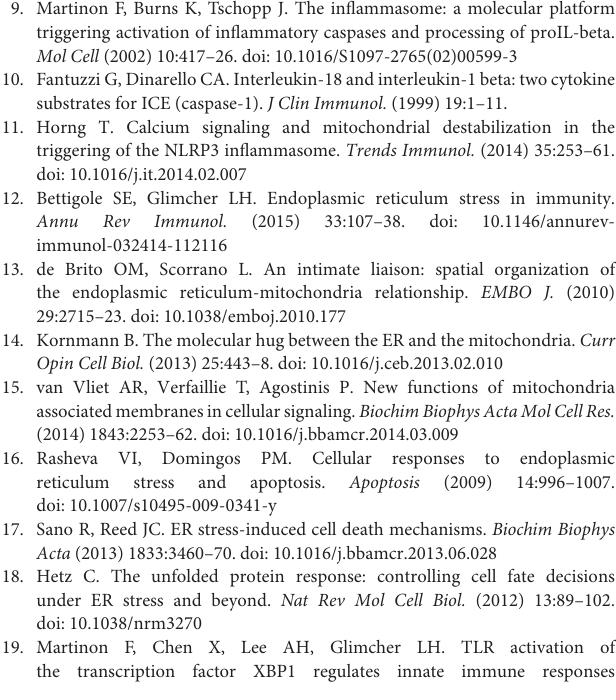
Supplementary Figure 3 | ERS mediates M. bovis -induced inflammasome activation in vivo . Related to Figure 6 . (A) ELISA analysis of serum TNF- α and IL-6 in mice treated with or without 4-PBA (18.6 mg/mouse/day) and infected with M. bovis (CFU 200) ( n = 3). (B) Clinical scores of mice infected with M. bovis (CFU 200) for 3 weeks or 6 weeks in the presence or absence of 4-PBA (18.6 mg/mouse/day). (C) Bacterial burden (acid-fast staining) in the lung of mice infected with M. bovis (CFU 200) for 3 weeks or 6 weeks in the presence or absence of 4-PBA (18.6 mg/mouse/day). 4-PBA, 4-phenyl butyric acid, ERS inhibitor, 18.6 mg/mouse/day; CFU, colony forming units ( n = 3). The data shown are the mean ± SD. ∗∗∗ P < 0.001, n.s., not significant. P -values were analyzed by using Student’s t -test. (C) Scale bar = 10 µ